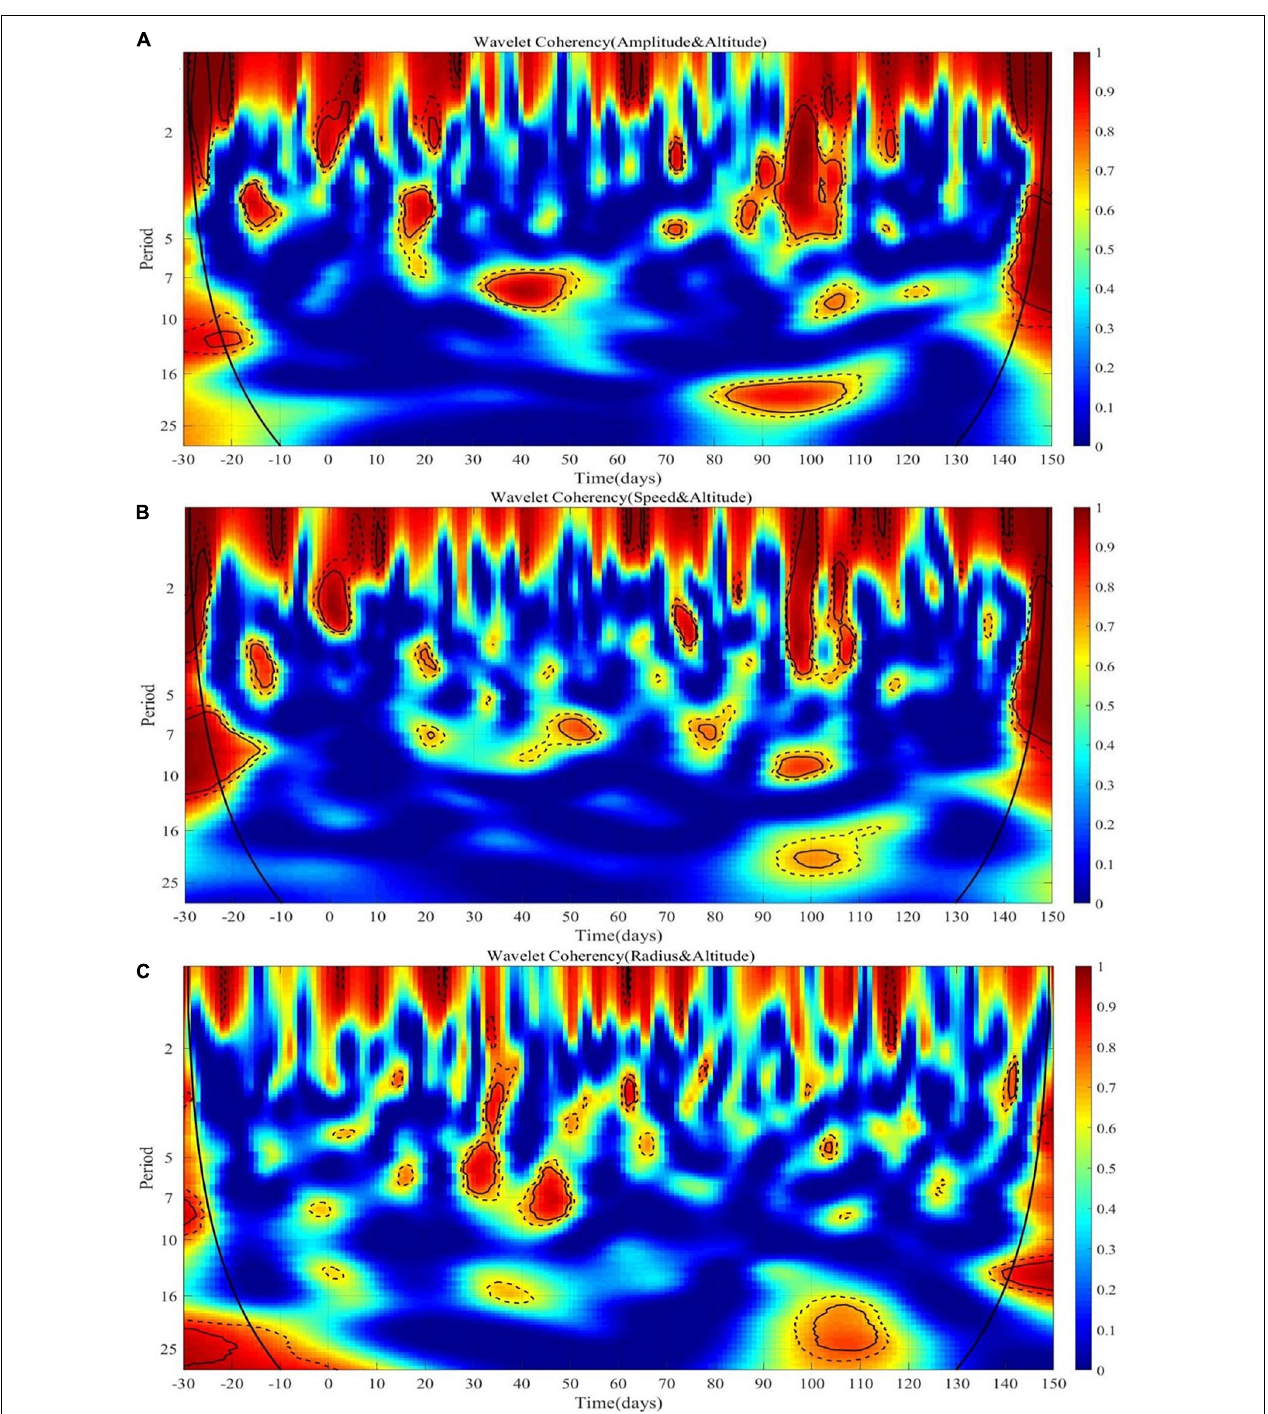
FIGURE 7 | Wavelet coherence mapping. (A) Wavelet coherence map between mesoscale eddy amplitude and topography. (B) Wavelet coherence map between rotation speed of mesoscale eddy and topography. (C) Wavelet coherence map between mesoscale eddy radius and topography.